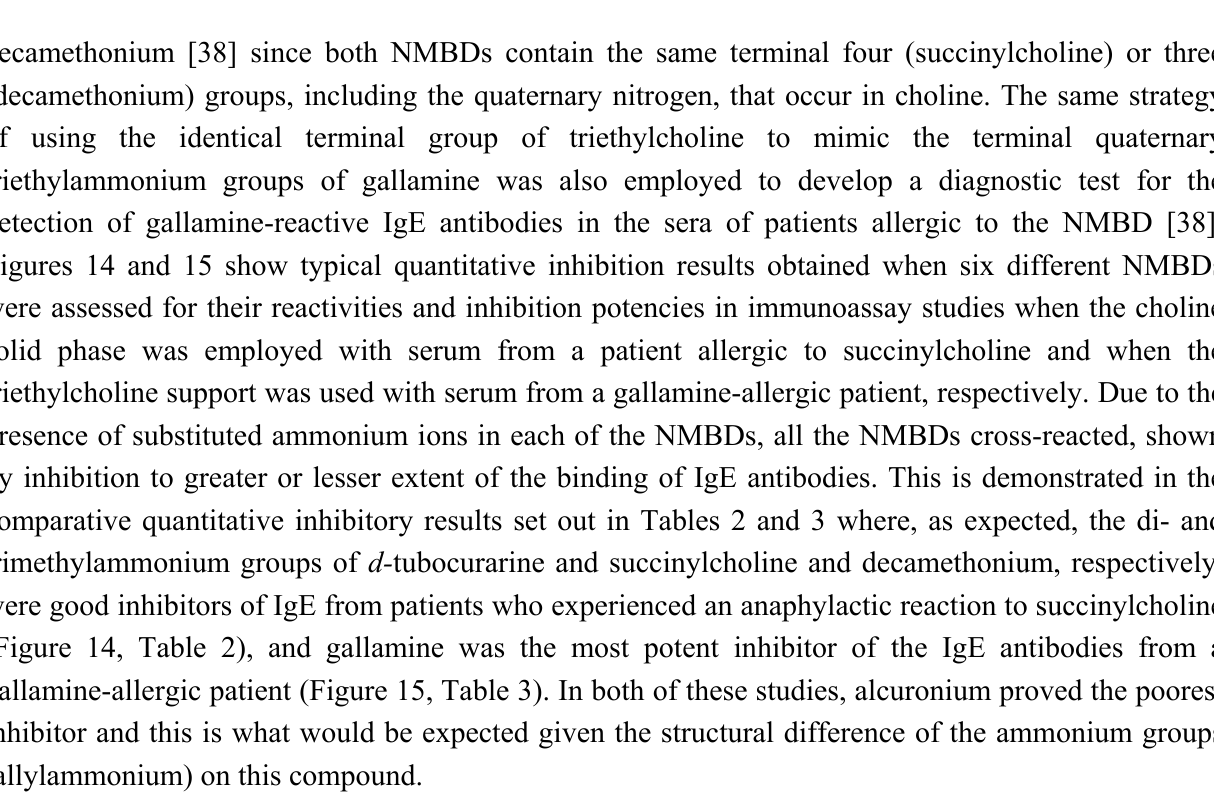
Figure 14. Demonstration of recognition of NMBDs by IgE antibodies in serum from a patient allergic to succinylcholine and dose-dependent inhibition results showing cross- reactions between the drugs using a choline-Sepharose covalent complex as solid phase in the immunoassay. See also Table 2. From Harle DG et al. [38]. Reproduced with permission from Elsevier